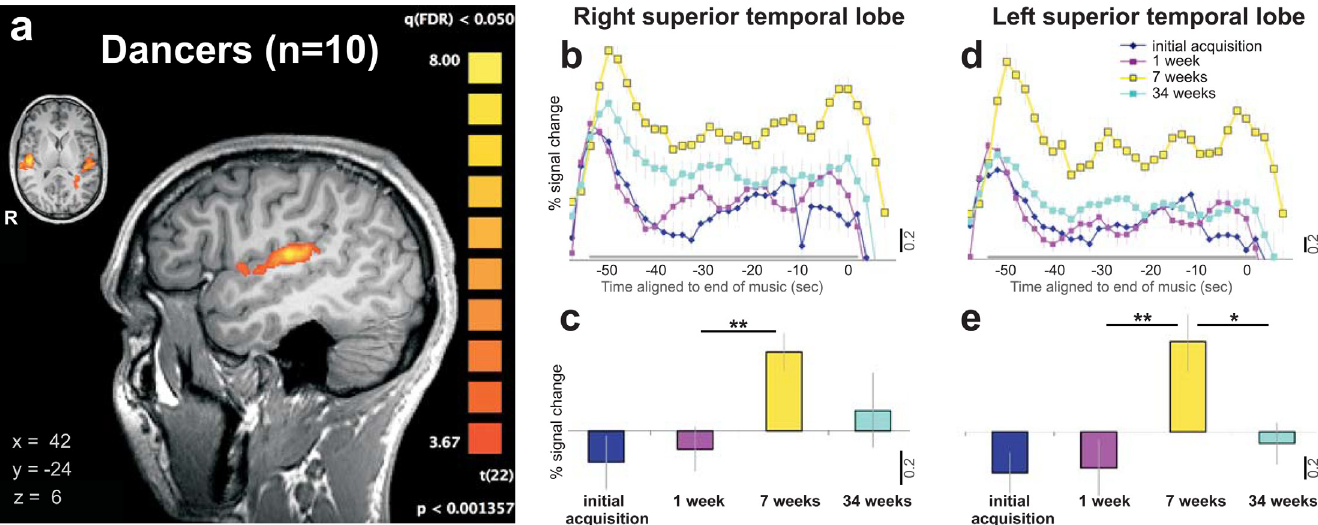
Fig 2. Auditory activation in music-visualization task. All figures show the average activity across participants using an RFX GLM, p < 0.05, FDR corrected. a , Auditory activation in the music-visualization task (parasagittal view is of right hemisphere). b , Music-visualization task: Percent of BOLD signal change across the four scans in right superior temporal lobe. c , Music-visualization task: Average BOLD signals of each of the four scans in right superior temporal lobe (taken from the gray period highlighted at the bottom and averaged in 2b). Signal increased from the second to the third scan ( p < 0.01, paired t -test). d , Music-visualization task: Percent of BOLD signal change across the four scans in left superior temporal lobe. e , Music-visualization task: Average BOLD signals of each of the four scans in left superior temporal lobe (taken from the gray period highlighted at the bottom of 2d and the averaged points in 2d). Signal increased from the second to the third scan ( p < 0.05, paired t -test), and decreased from third to fourth scan ( p < 0.05, paired t -test). All error bars represent the s.e.m. Scale bar represents 0.2 percentage BOLD signal change. * signifies p < 0.025 trend and ** signifies p < 0.05 corrected for Bonferroni multiple comparisons.